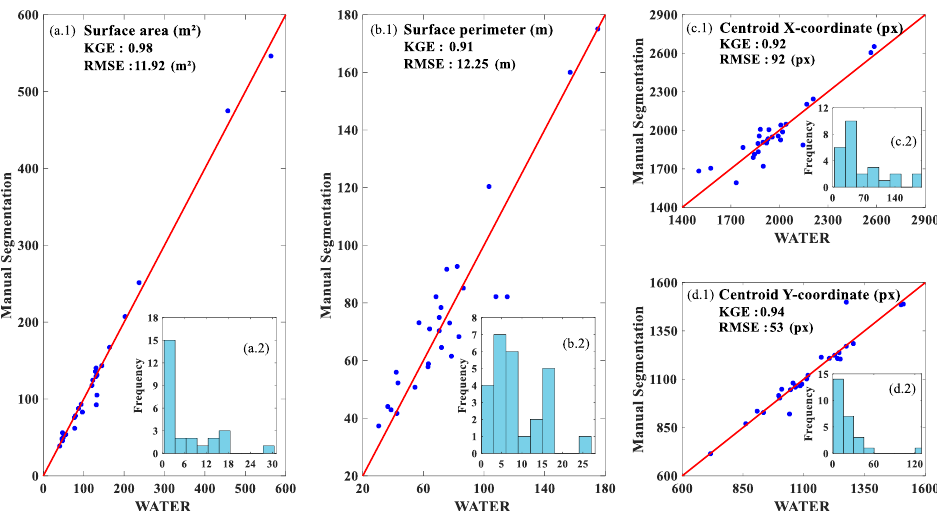
perimeter was at − 6.2%, and that for centroid coordinates in x and y was at (0.1%, 0.0%). Table 2. Summary of WATER performance as a function of water extent area, water extent perime- ter, and centroid coordinates. Errors were computed as (𝑉 𝑊𝐴𝑇𝐸𝑅 − 𝑉 𝑀𝑎𝑛𝑢𝑎𝑙 )/𝑉 𝑀𝑎𝑛𝑢𝑎𝑙 , where 𝑉 𝑊𝐴𝑇𝐸𝑅 is the variable in question retrieved by WATER and 𝑉 𝑀𝑎𝑛𝑢𝑎𝑙 is the variable in question retrieved by manual segmentation.